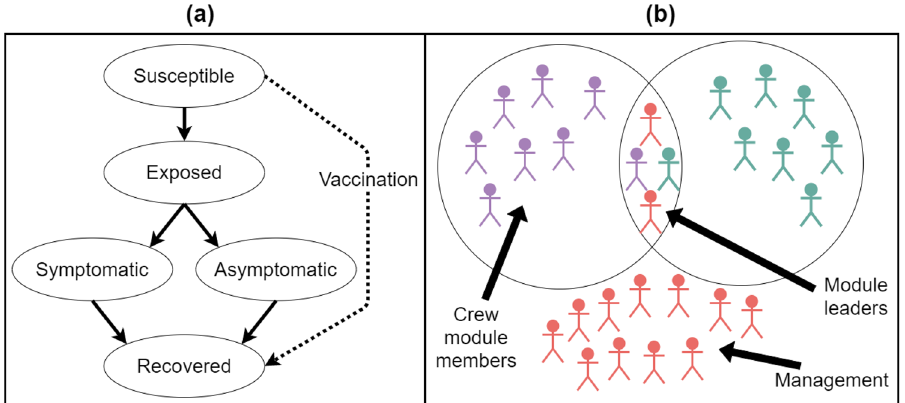
Figure 2. ( a ) The possible viral states which individuals may travel through in simulations. The arrows indicate possible paths that individuals may take through the viral states. An individual may move directly from susceptible to recovered only if vaccinated. ( b ) Interactions between personnel on a single fire. Crew module members (individuals of the same color) interact only with other members of the same module, with the exception of module leaders, who interact both with their module members and with other module leaders. Management personnel cannot effectively form modules and thus interact with all other management personnel as well as a proportion who interact with the crew module